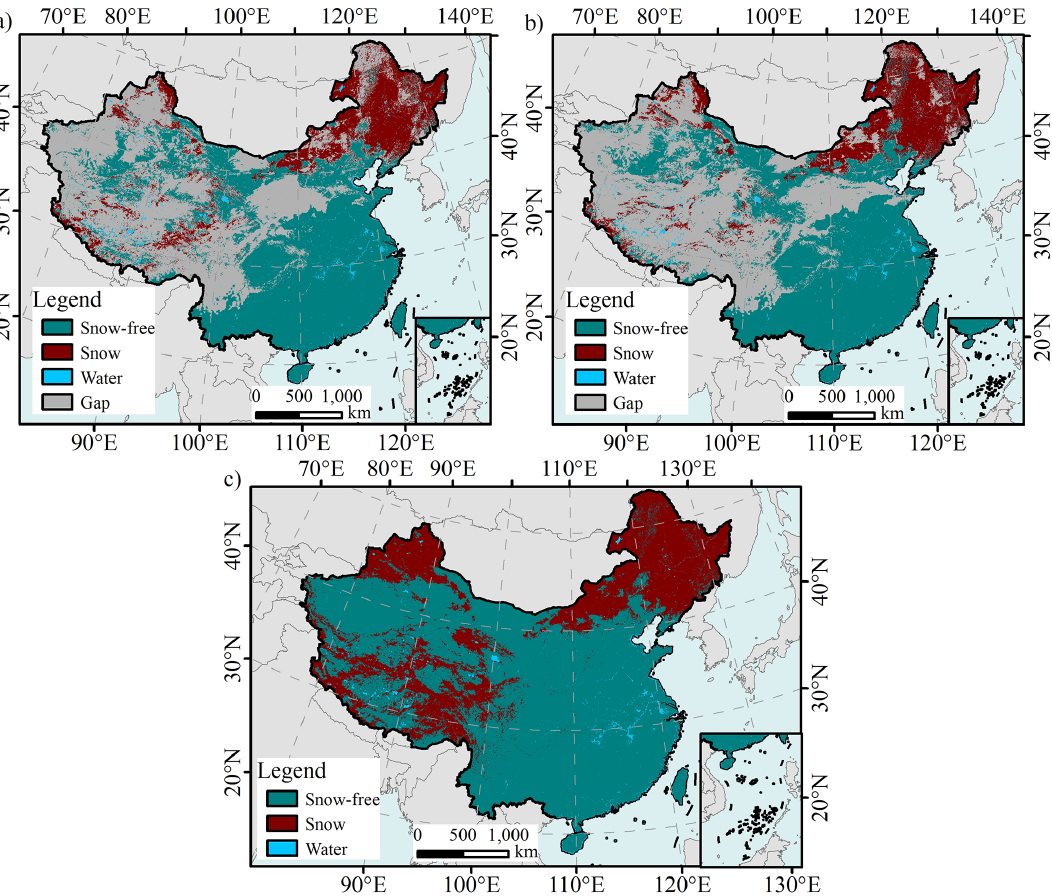
Figure 7. NIEER MODIS SCE product on 4 January 2020: (a) Terra-MODIS SCE dataset; (b) Aqua-MODIS SCE dataset; (c) CGF-MODIS SCE dataset. Table 5. Validation results of the new NIEER MODIS SCE product with reference to CMA ground